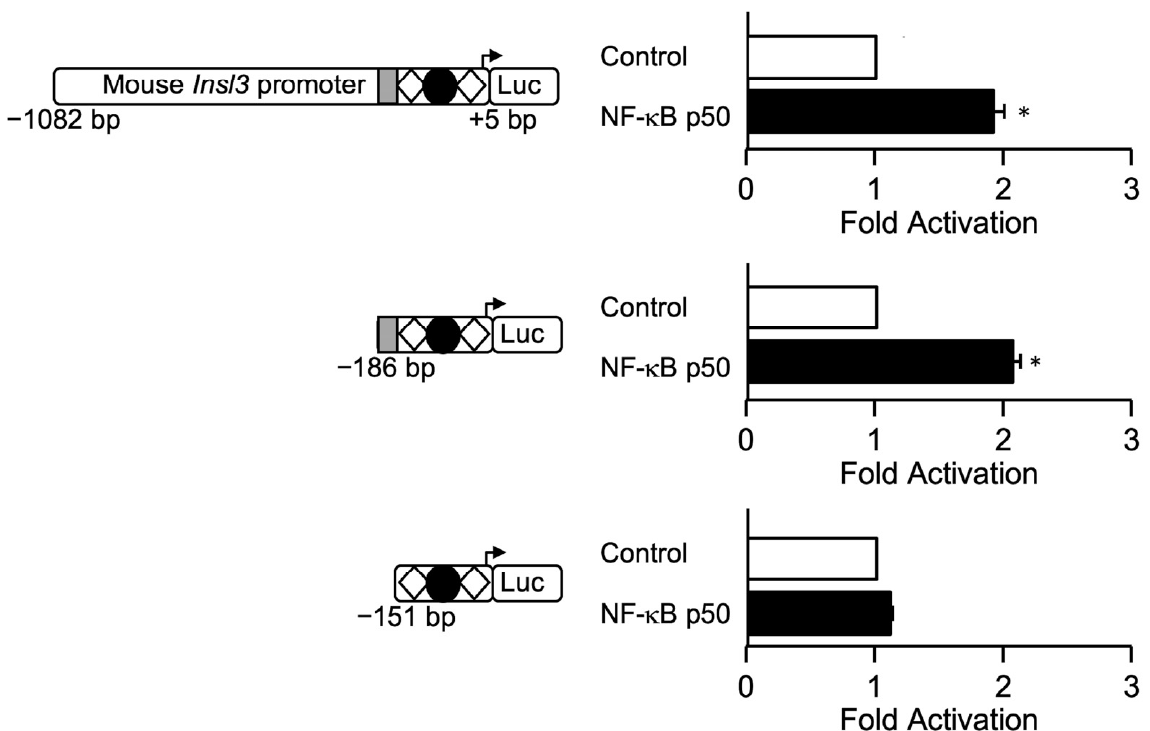
Figure 7. NF- κ B p50-dependent activation of the mouse Insl3 promoter requires the 35-bp region. MA-10 Leydig cells were transfected with three Insl3 promoter constructs ( − 1132 bp, − 186 bp, − 151 bp) along with an empty expression vector (open bar) or an expression vector for NF- κ B p50 (black bars). The position of previously identified binding sites for SF1 (white diamonds) and COUP-TFII (black circle) is indicated. The grey box represents the 35-bp sequence responsible for 70% of Insl3 promoter activity. Results are shown as Fold Activation over control ± SEM. An asterisk (*) represents a statistically significant activation compared to control (empty expression vector, value set at 1, p < 0.05).